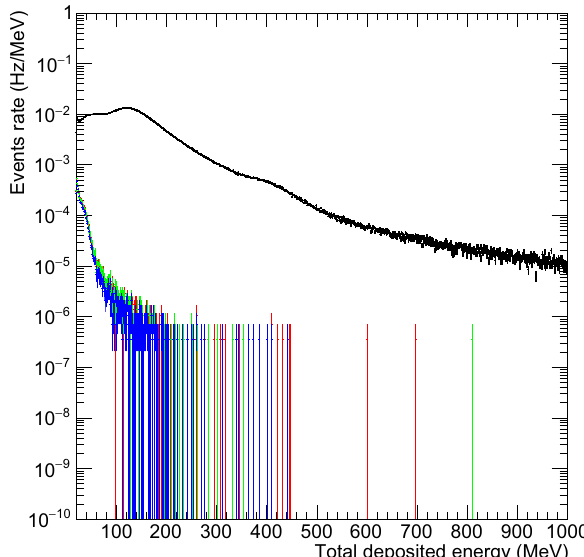
Fig. 18 Comparison between data and MC simulation for the OV. The distributions show the response of SiPM#4 to muons traversing the detector with the trajectory number 0. The two peaks correspond to different muon topologies